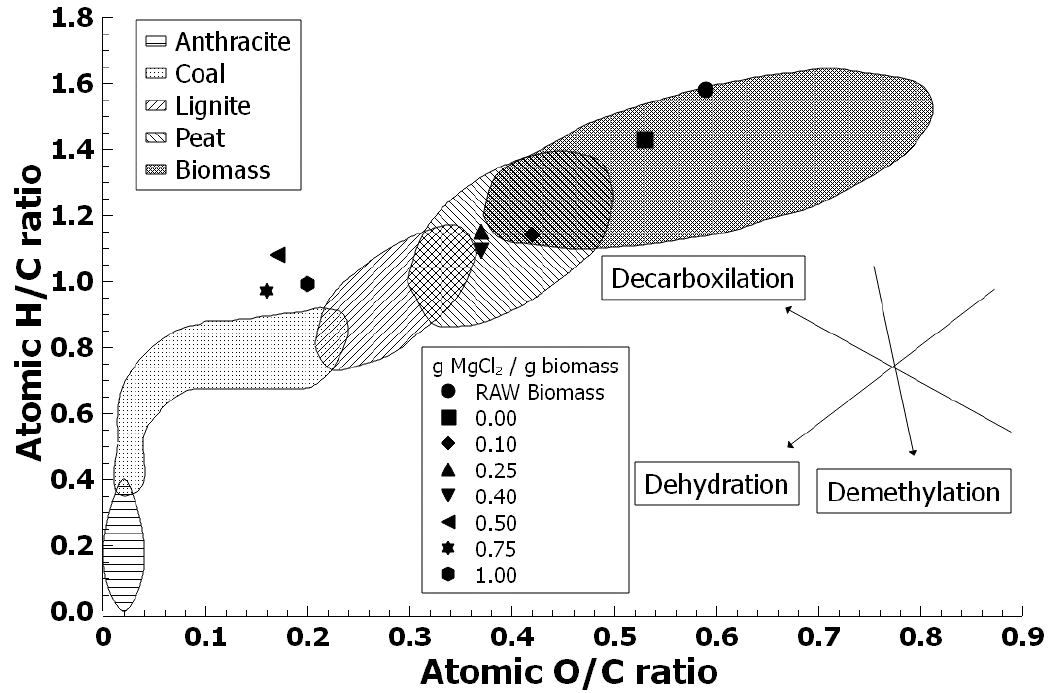
Figure 5. Van Krevelen diagram.